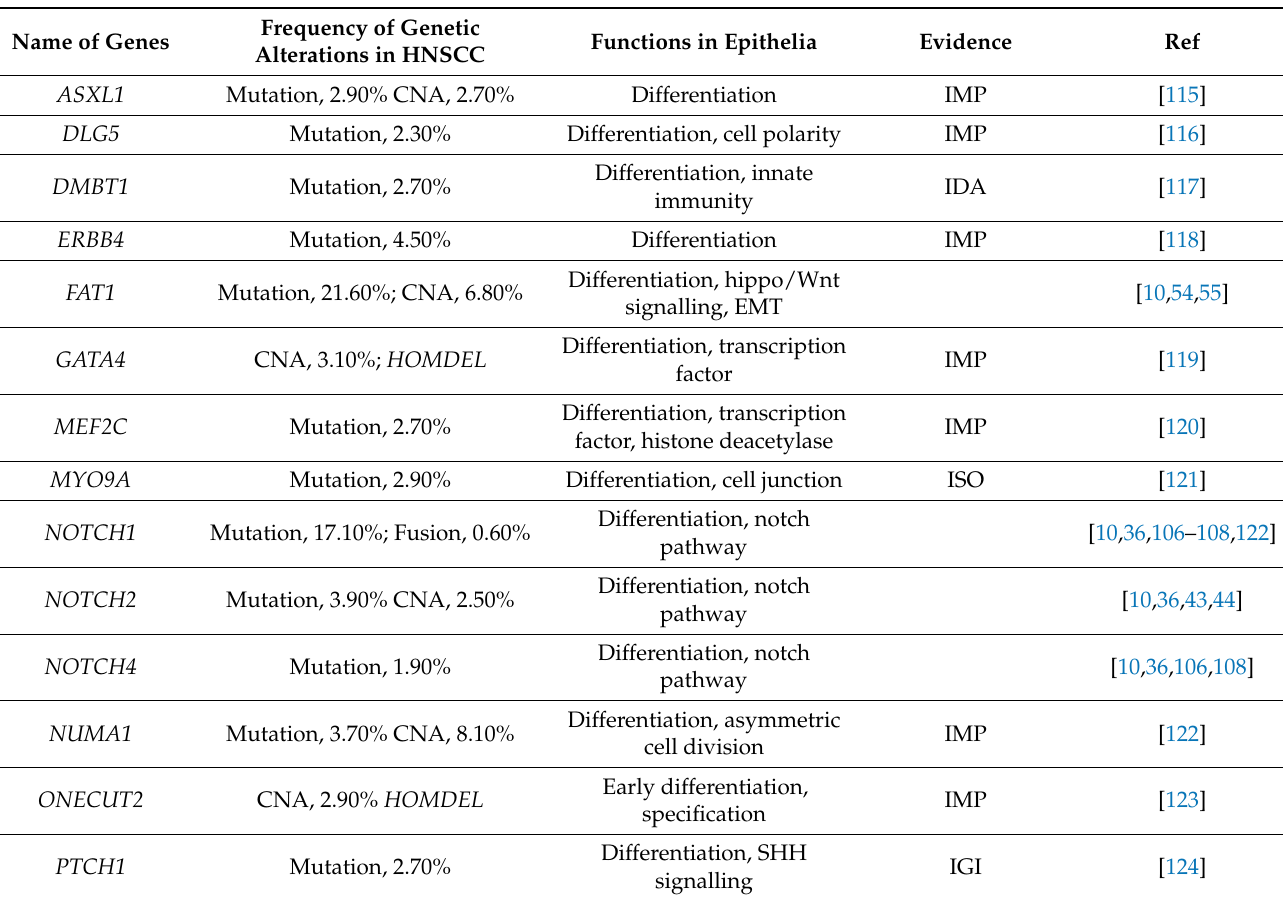
Table 1. Frequency of genetic alterations targeting differentiation and terminal differentiation genes in HNSCC (original